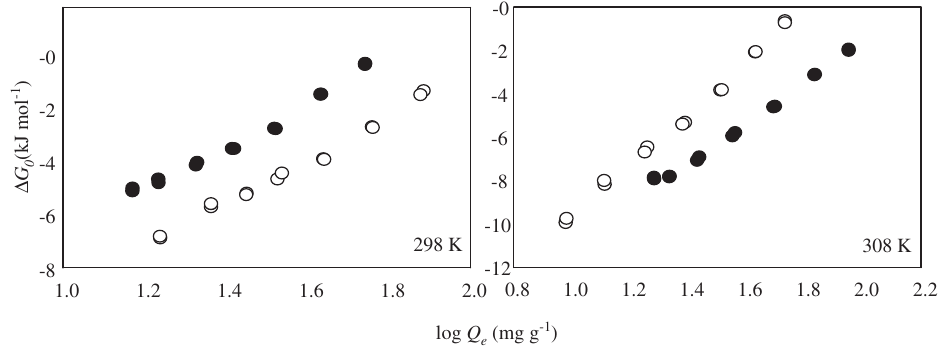
Figure 4: Plots of standard Gibbs free energy change ( Δ G 0 ) for adsorption of methylene blue at 298 K and 318 K. Circles (● and ○) represent multi-walled carbon nanotubes (MWCNTs) and oxidized MWCNTs (MWCNTs-Ox),